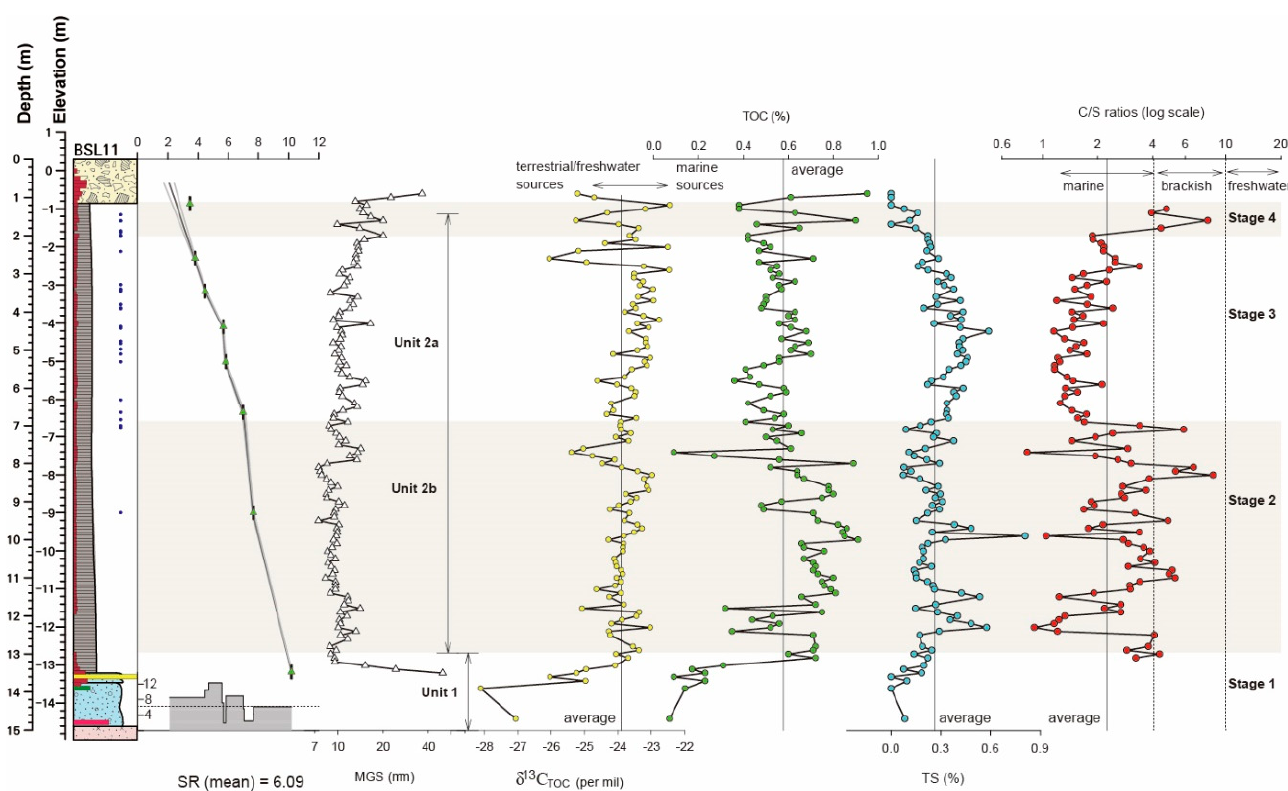
Figure 3. Stratigraphic section, age–depth curve, sedimentation rates, and sedimentary proxies for core BSL11 (MGS: median grain size, TOC: total organic carbon, TS: total sulfur, C/S: carbon/sulfur, and SR: sedimentation rate). Horizontal bars and blue dots in the stratigraphic section indicate grain size and shell locations.